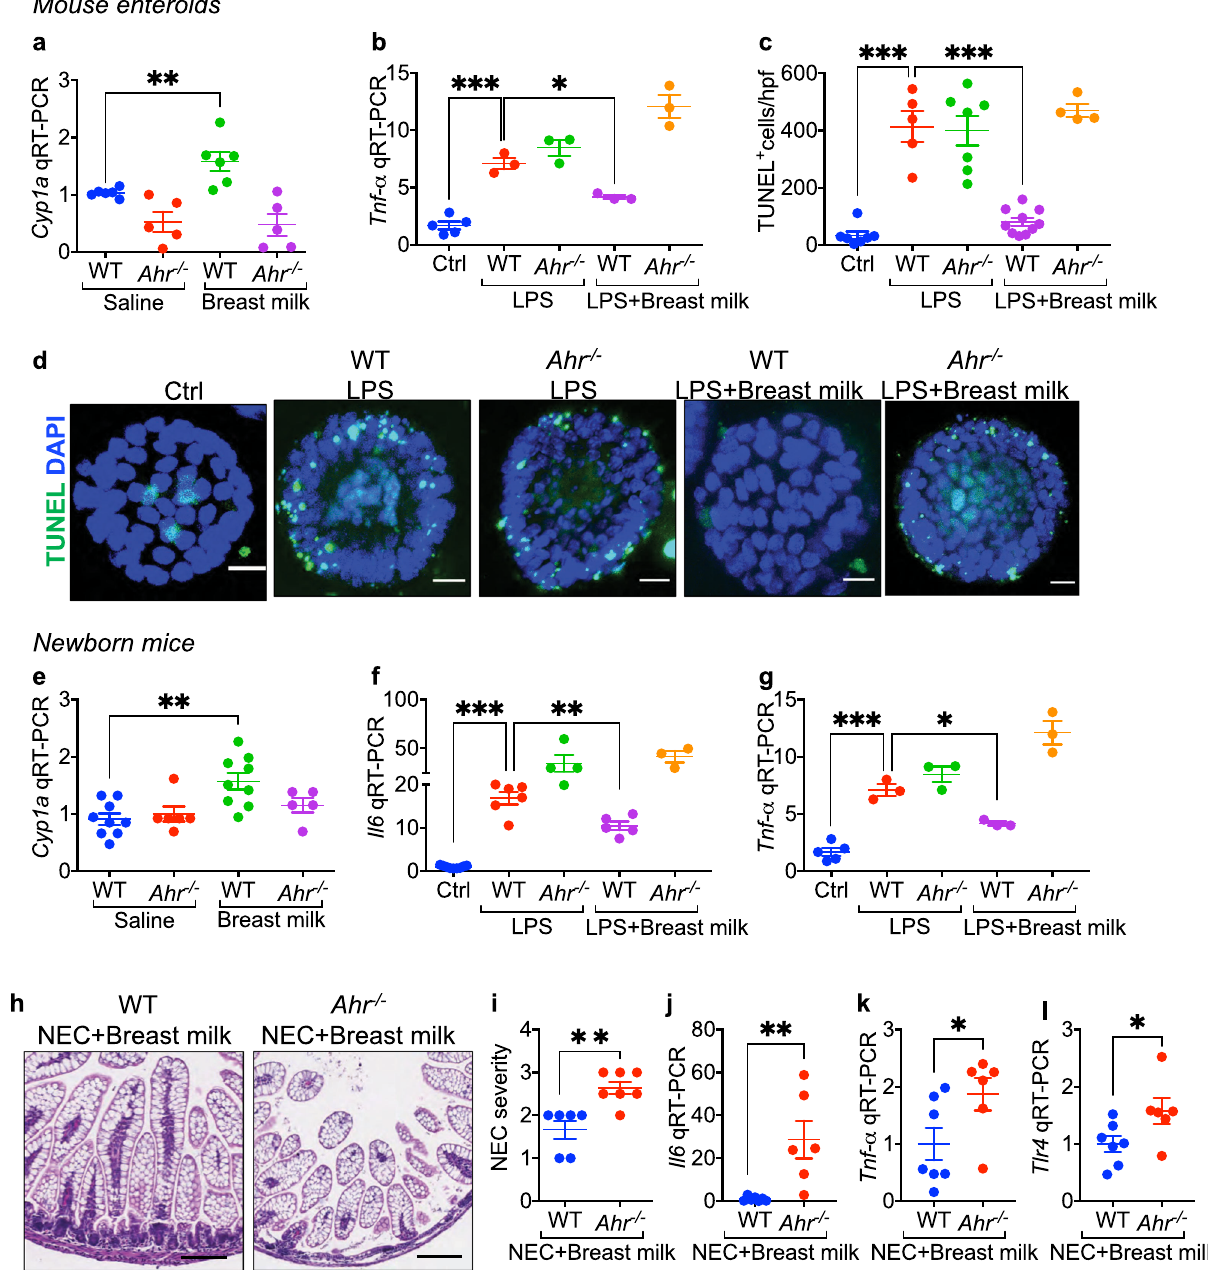
Fig. 5 Breast milk activates AHR on the intestinal epithelium and protects against experimental NEC in newborn mice. a , b qRT-PCR showing the expression of Cyp1a1 ( a , n = 6, 5, 6, 5 wells of enteroids, WT saline vs WT breast milk p = 0.0096) and Tnf- α ( b , n = 5, 3, 3, 3, 3 wells of enteroids, Ctrl vs WT LPS p = 0.0001, WT LPS vs WT LPS + breast milk p = 0.0325) in mouse intestinal enteroids from wild-type (WT) and Ahr -/- mice, treated with saline or LPS in the presence or absence of breast milk. c , d LPS-induced apoptosis in enteroids measured by TUNEL assay in wild-type and Ahr -/- mouse enteroids as quanti fi ed ( c , n = 7, 5, 7, 10, 4 enteroid sections, Ctrl vs WT LPS p < 0.0001, WT LPS vs WT LPS + breast milk p < 0.0001) and revealed ( d ) by confocal microscopy. TUNEL, green signal; nuclei (DAPI, blue signal). e – g qRT-PCR showing the expression of Cyp1a1 ( e , n = 9, 6, 9 5 mice, WT saline vs WT breast milk p = 0.0026), Il6 ( f , n = 9, 6, 4, 5, 3 mice, Ctrl vs WT LPS p = 0.0039, WT LPS vs WT LPS + breast milk p = 0.0070) and Tnf- α ( g , n = 5, 3, 3, 3, 3 mice, Ctrl vs WT LPS p = 0.0001, WT LPS vs WT LPS + breast milk p = 0.0325) in wild-type and Ahr -/- mice treated with saline, LPS and/or breast milk as indicated. h – l Representative H&E- stained section ( h ), NEC severity score ( i , n = 6, 7 mice, p = 0.0023), and the ex p ression of Il6 ( j , n = 7, 6 mice, p = 0.0056), Tnf- α ( k , n = 7, 6 mice, p = 0.0221) and Tlr4 ( l , n = 7, 6 mice, p = 0.0465) in wild-type and Ahr -/- mice induced to develop NEC in the presence or absence of breast milk as indicated. Scale bars in d , 10 μ m. Scale bars in h , 100 μ m. All data are presented as mean values ± SEM. * p < 0.05, ** p < 0.01, *** p < 0.001, p values obtained either from two-sided t tests or one-way ANOVA followed by multiple comparisons. Each dot in graphs represents data from an individual well of enteroids, section of enteroids, or an individual mouse.